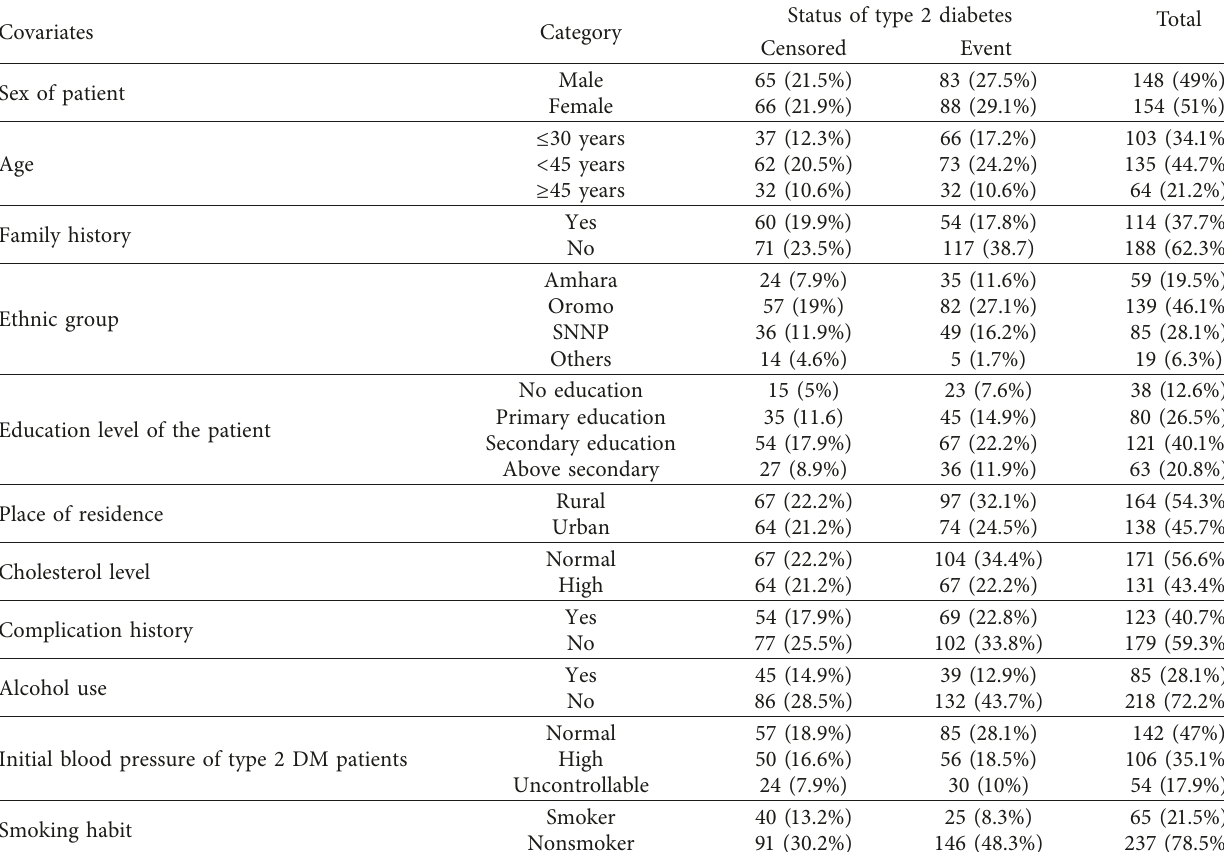
Table 1: Summary statistics for categorical covariates included in the study.